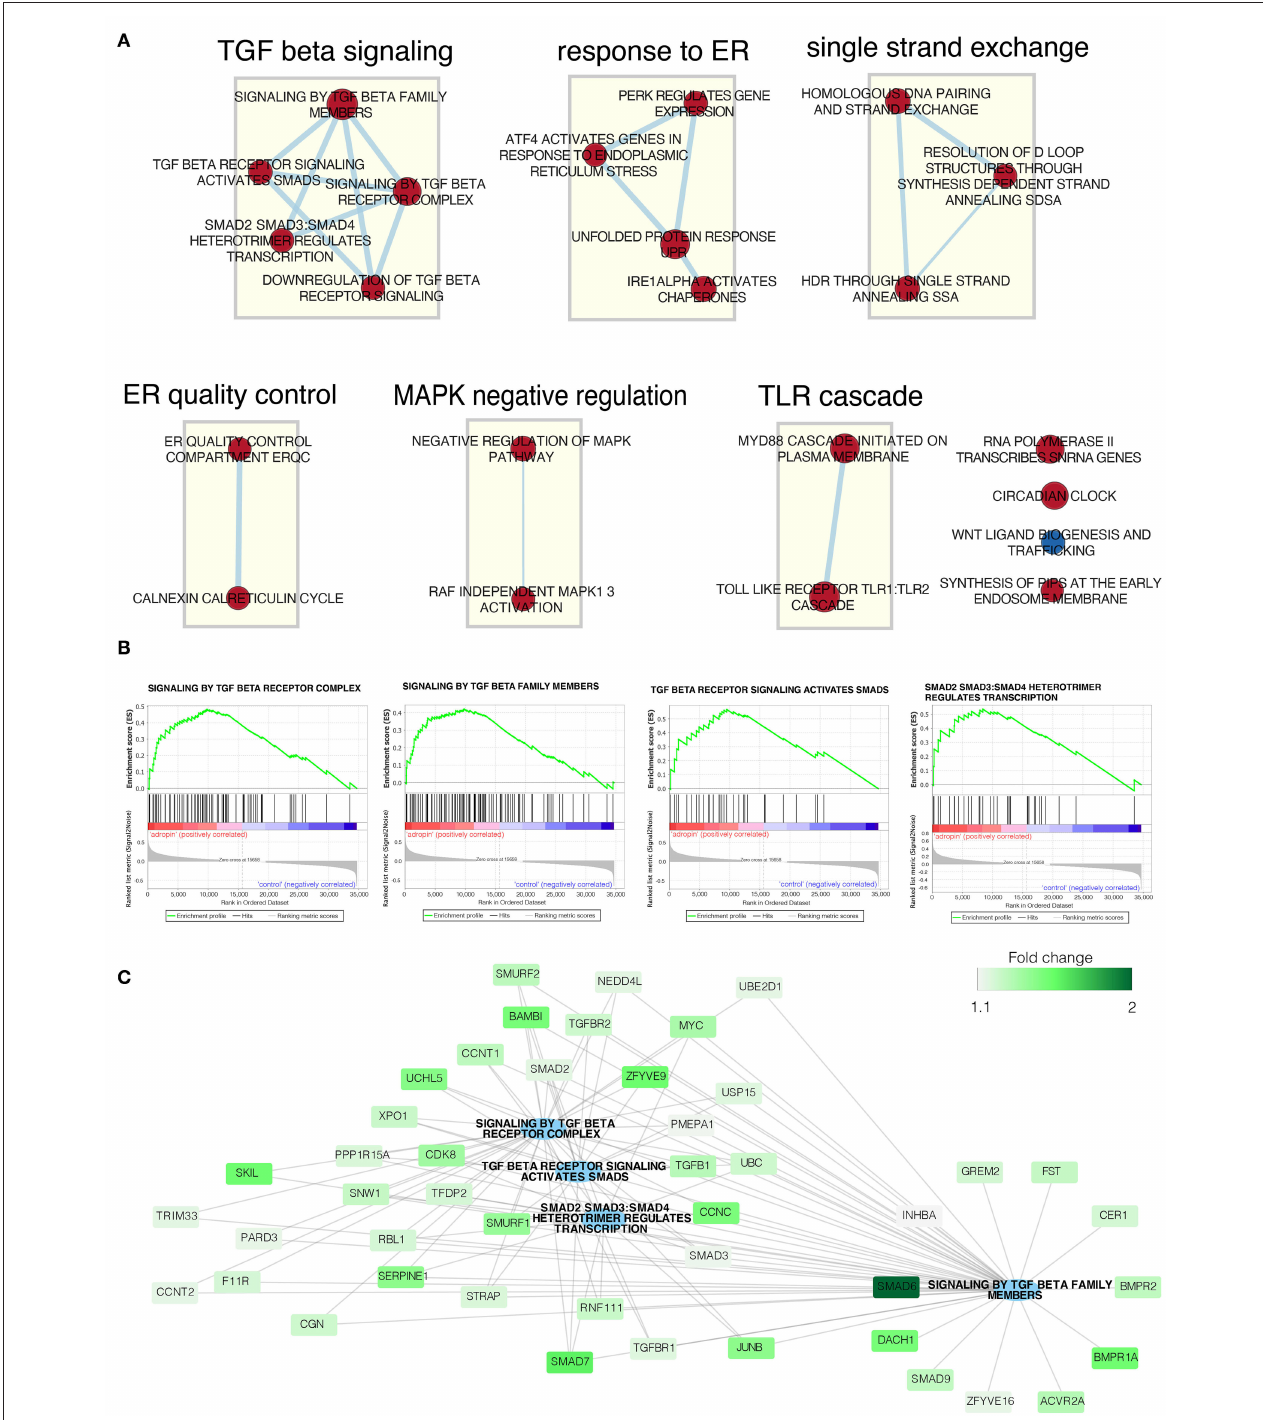
FIGURE 9 | Gene set enrichment analysis affected by adropin compared to control group. (A) Enrichment map of gene sets regulated by adropin (red = activated, blue = inhibited). The thickness of the connecting line corresponds to the level of gene matching to individual terms. (B) Enrichment plot of: “Signaling by TGF beta receptor complex,” “Signaling by TGF beta family members,” “TGF beta receptor signaling activated by SMADs,” “SMAD2 SMAD3:SMAD4 heterotrimer regulates transcription.” Each of the graphs shows the positive value of the enrichment score (ES) indicating activation of genes forming these processes under the influence of adropin. (C) Interaction network between genes with the highest impact on the biological processes analyzed. Fold change values for individual genes are marked by color scale.